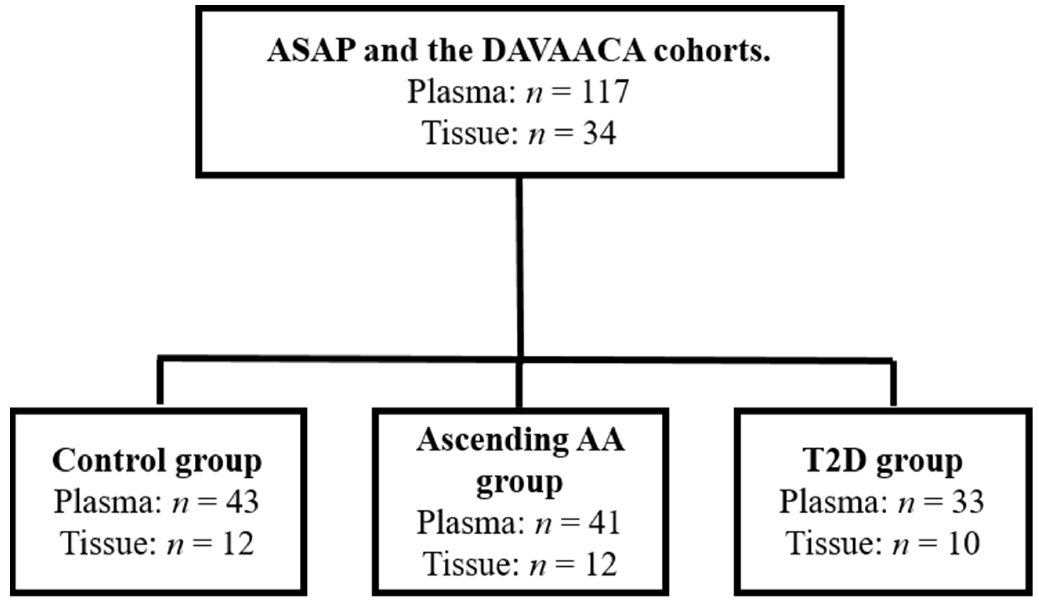
Figure 1. Study groups.